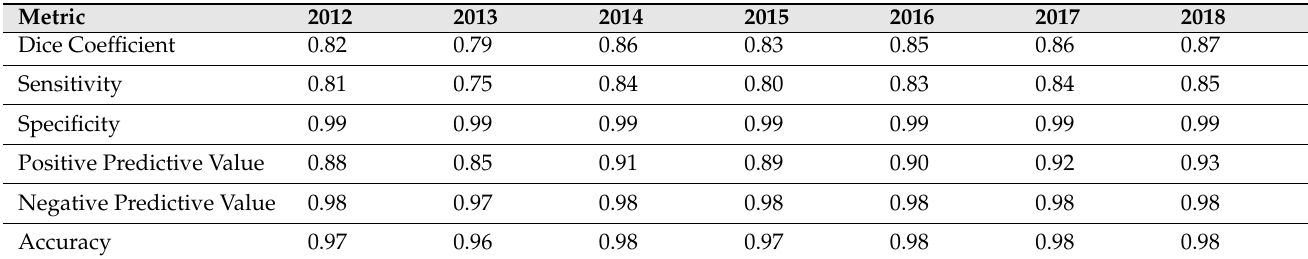
Table 14. Performance Metrics for BraTS